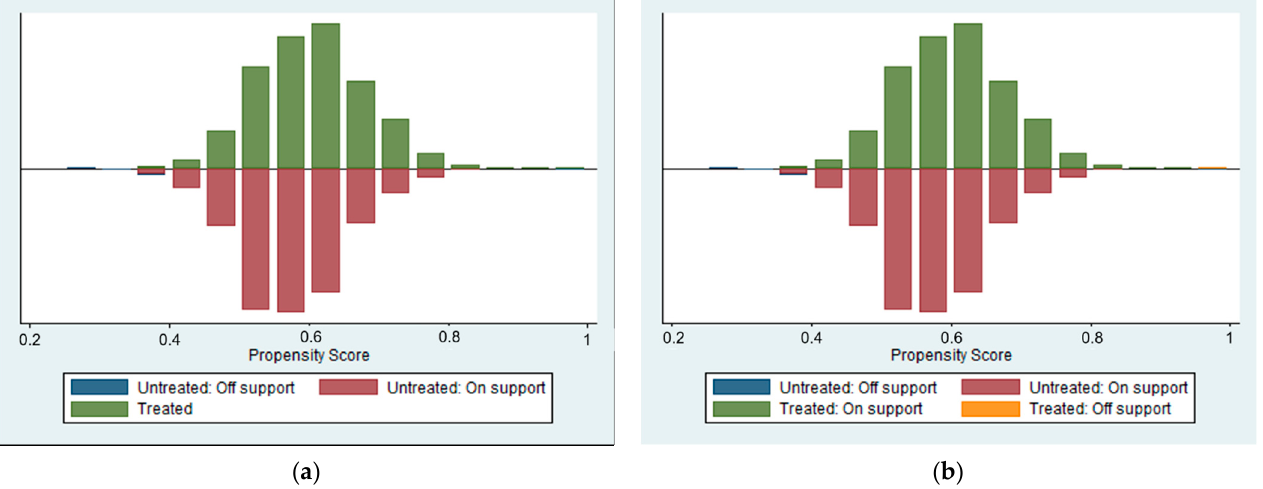
Figure 3. Propensity score distribution and common support for propensity score estimation: ( a ) with nearest neighbor matching; ( b ) with kernel-based matching.